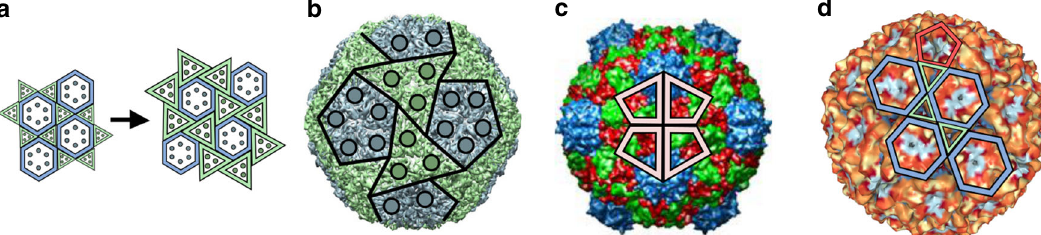
Fig. 5 More general applications of the Archimedean lattice models in virology. a Rescaling of the triangular faces, with respect to the hexagonal ones, results in a gyrated version of the trihexagonal lattice in which proteins occupying different types of faces have identical footprints in the capsid surface. b The inner capsid of Pseudomonas phage phi6, a pseudo T ¼ 2 structure formed from 120 chains, is an example of a gyrated T t ð 1 ; 0 Þ lattice architecture. Its symmetry equivalent chains, shown in blue and green respectively based on RCSB PDB 4BTQ (ref. 42 ), follow the layout of a surface architecture in which the surface areas of the triangular and pentagonal shapes occur in a ratio 3:5 (magenta), re fl ecting occupation by chains with comparable footprints (cid:1) (cid:3) on the capsid surface. c The kite tiling for Tobacco ringspot virus T D r ð 1 ; 0 Þ , with tiles shown superimposed on a fi gure adapted from the ViPER data base (Tobacco ringspot virus: PDB-id 1a6c 43 ). d A T t ð 2 ; 1 Þ lattice, shown superimposed on a surface representation in rainbow colouring of RCSB PDB 2XYY 66 , captures the outermost features of bacteriophage P22, with timers indicating the positions of the crevasses between the radially most distal features of the capsomers. Triangles also mark the positions of the trimer interactions between capsomers at a lower